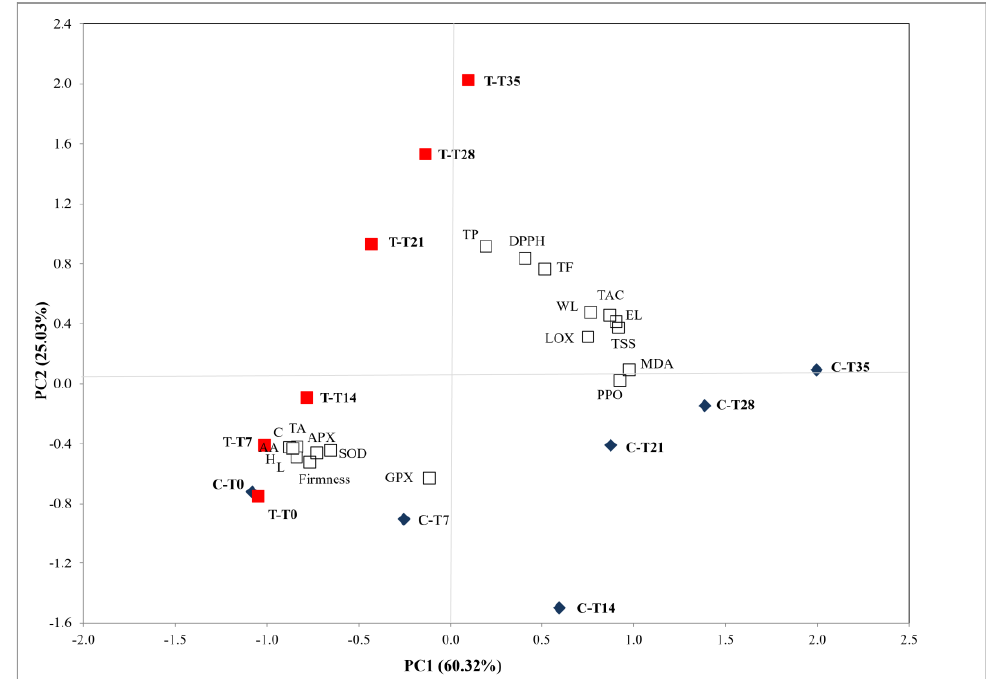
Figure 3. 2D-principal component analysis plot of analyzed attributes in ‘Black Golden’ Japanese plum at harvest (C-T0: uncoated fruit; T-T0 chitosan-coated fruit 0), 7 (C-T7: uncoated fruit; T-T7 chitosan-coated); 14 (C-T14: uncoated fruit; T-T14 chitosan-coated); 21 (C-T21: uncoated fruit; T-T21 chitosan-coated); 28 (C-T28: uncoated fruit; T-T28 chitosan-coated); and 35 (C-T35: uncoated fruit; T-T35 chitosan-coated) days of cold storage (WL: weight loss; TSS: total soluble solid content; TA: total titratable acidity; Firmness; L: L* value; H: hue angle; C: Chroma; TP: polyphenol content; TF: flavonoid content; TAC: total anthocyanin content; AA: acid ascorbic content; DPPH: radical scavenging activity; EL: electrolyte linkage; APX: ascorbate peroxidase; SOD: superoxide dismutase; GPX: guaiacol peroxidase; LOX: lipoxygenase; PPO: polyphenol oxidase; MDA: malondialdehyde content).